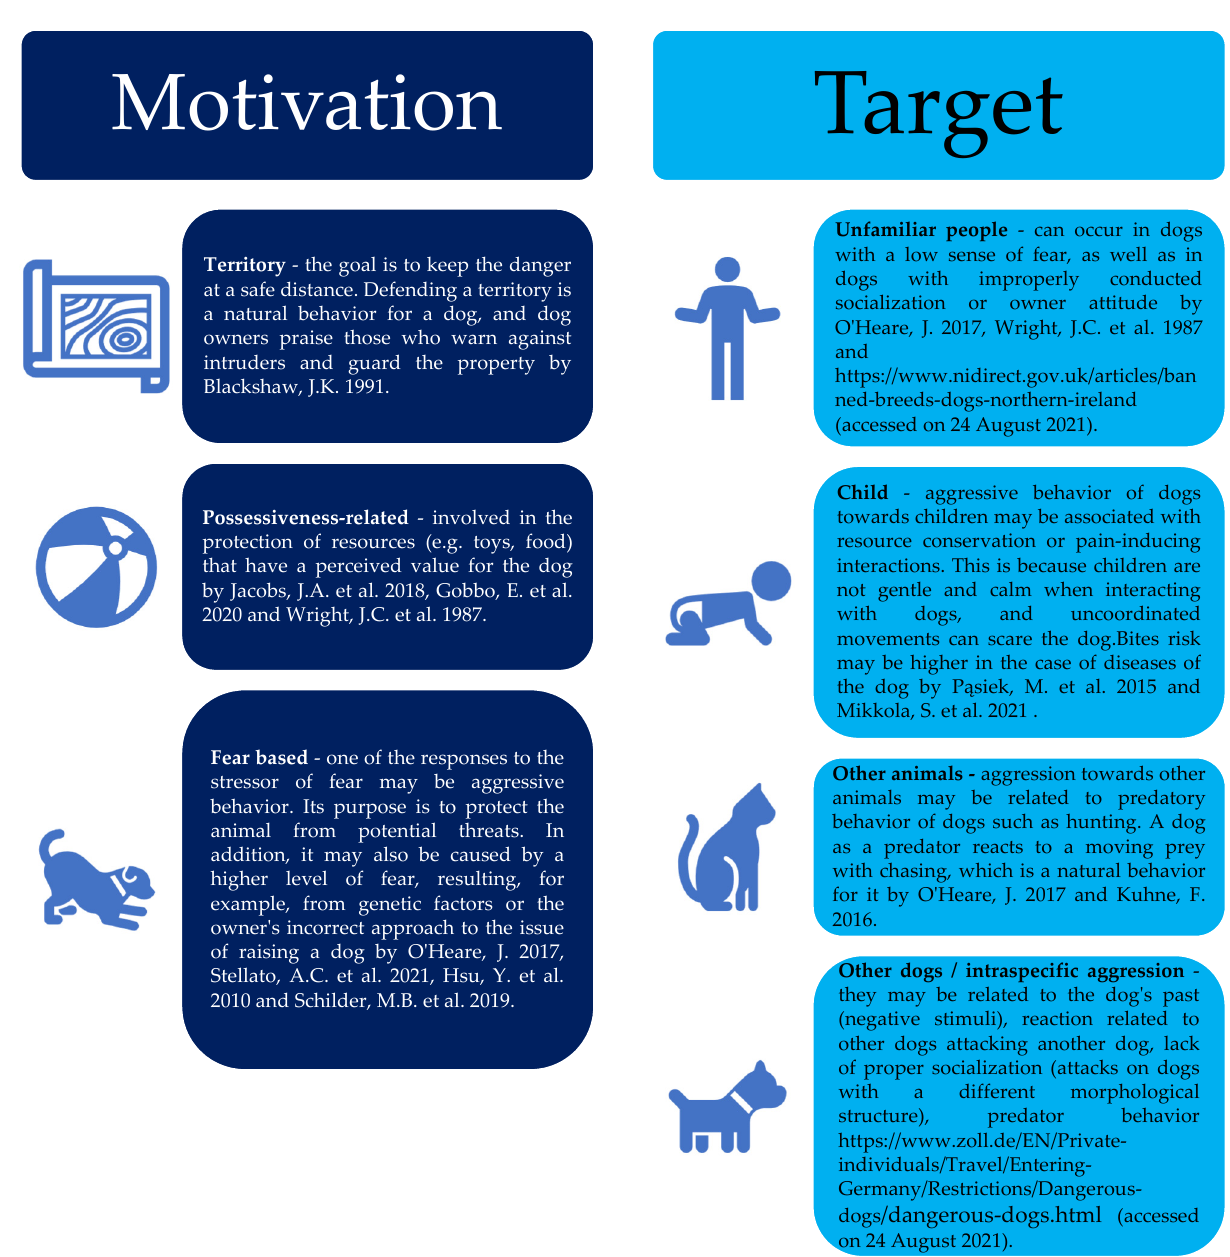
Figure 1. Selected types of aggression in dogs depend on motivation target [9,13,20,23–32]. Aggression is a natural part of dog behavior, and it is part of the ethogram. However, excessive aggression disrupts the relationship between the dog and its environment [17– 20]. Aggression can be based on motivational basis (territorial-, fear-, possessiveness- related, etc.) or target basis (stranger-, owner-, dog-directed, etc.) [33]. The change of motivation occurs most often when one of the dog’s needs has not been met. For example,